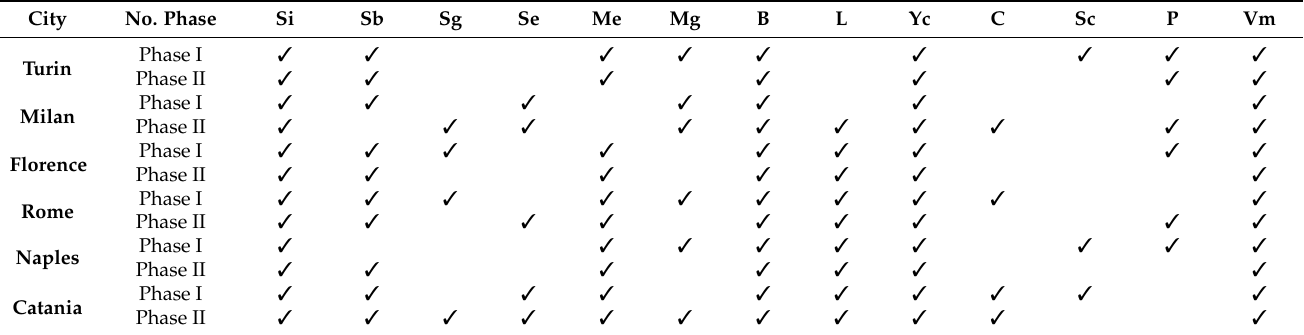
Table 9. Comparison of the explanatory variables selected by the EPR-MOGA technique in the Phases I and II. City No. Phase